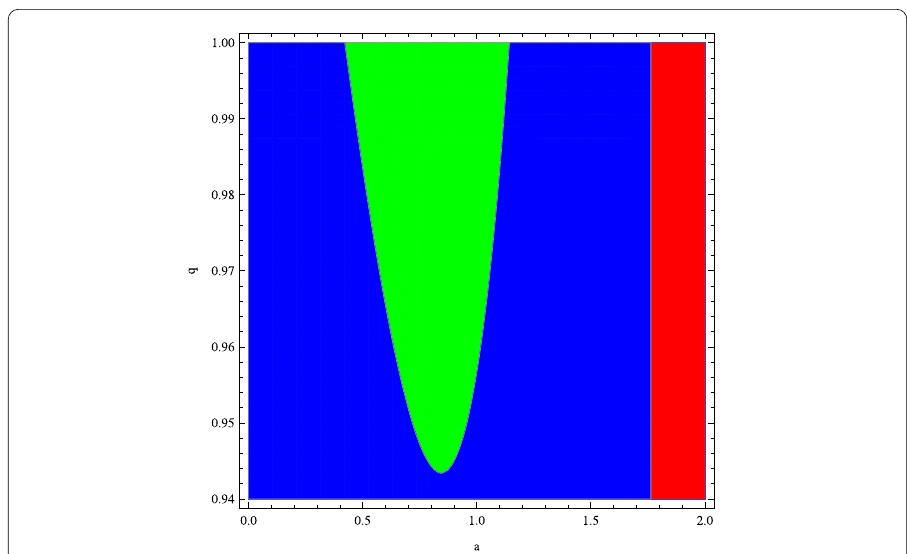
Figure 13 Stability regions of the fractional-order model (3) in ( a – q ) plane